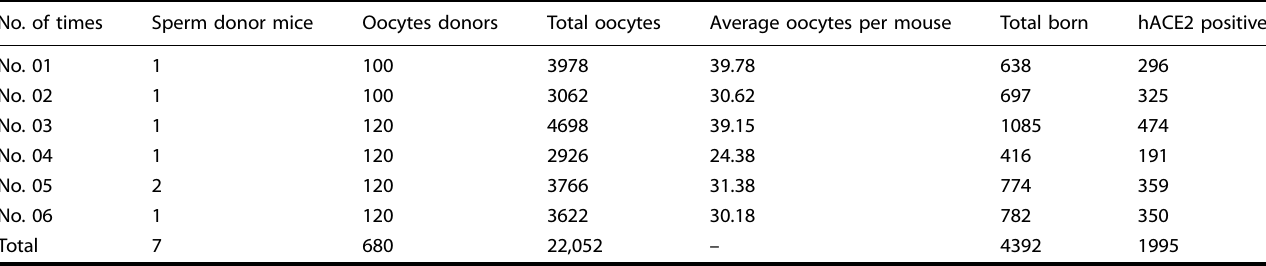
Table 8. Rapid breeding of hACE2-KI humanized mouse by in vitro fertilization (IVF) technology a No. of